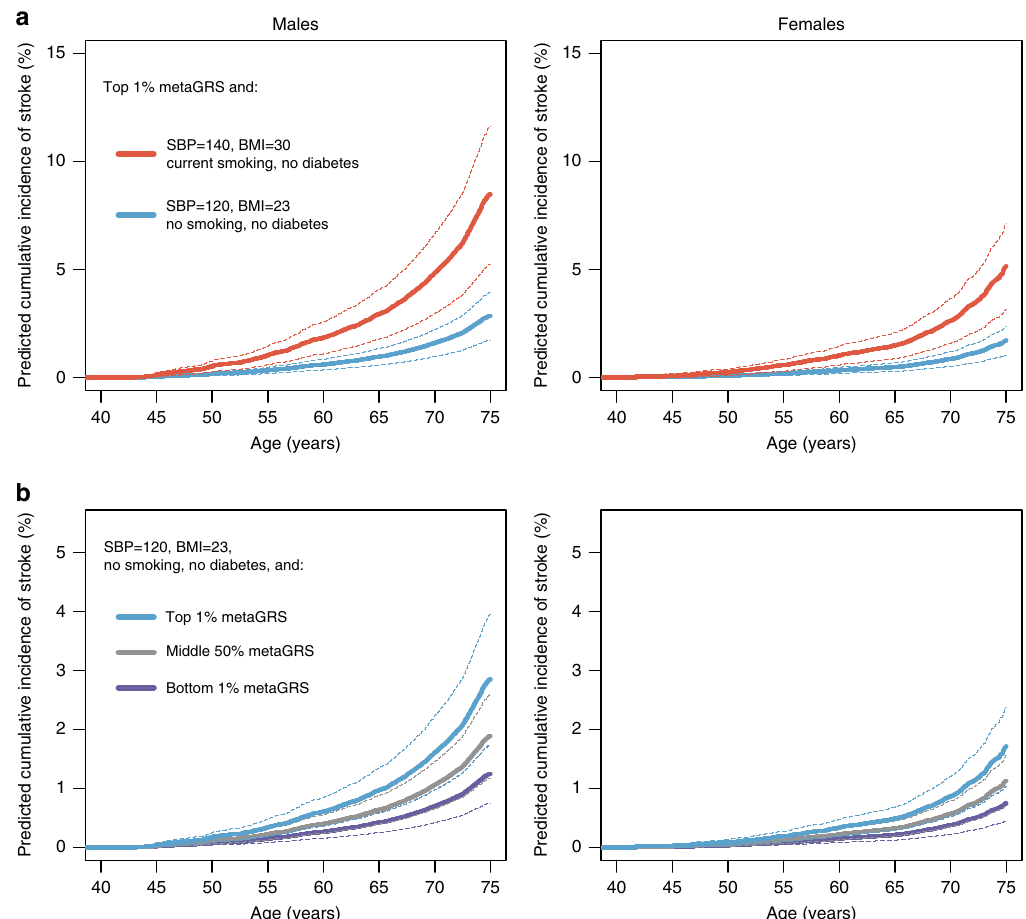
Fig. 5 Predicted cumulative incidence of ischaemic stroke. Shown is the predicted cumulative incidence of IS in subjects with either ( a ) high levels of the metaGRS along with different risk factor levels (red: outside the guidelines; cyan: within the guidelines); or ( b ) risk factors within accepted guidelines along with different levels of the metaGRS (cyan: top 1% of the metaGRS; grey: middle 50% of the metaGRS; dark blue: bottom 1% of the metaGRS). Results are based on the UKB validation set, excluding prevalent stroke events ( n = 390,849). Error bars represent 95% con fi dence